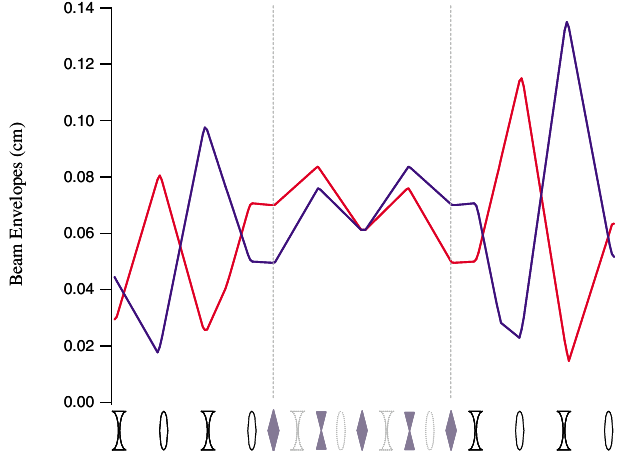
FIG. 7. (Color) Beam envelopes (horizontal in red and vertical in blue) for the 3F region of the FEL with the five skew quadrupoles (blue) activated and illustrating the exchange of horizontal and vertical phase spaces. The central four normal quadrupoles (dotted) are deexcited during reflector operation and the upstream and downstream quadrupoles (black) are used as betatron matching